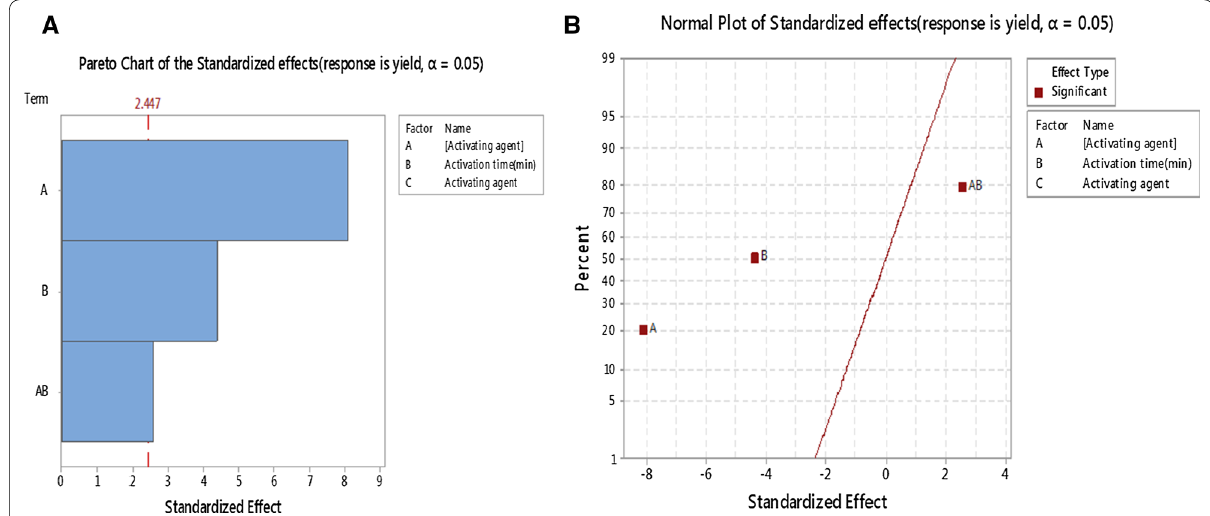
Fig. 1 a , b Pareto plot and normal plot of standardized effects of model parameters on the DGPAC